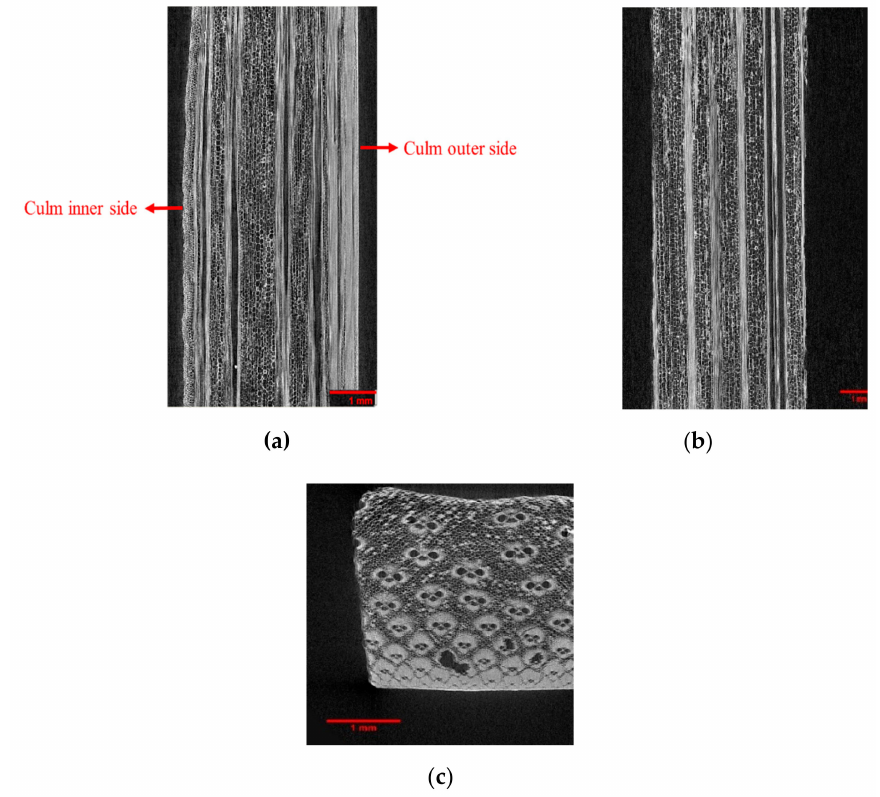
Figure 3. X-ray micro-CT images of virgin bamboo. ( a ) front view, ( b ) side view, and ( c ) top view. The white vertical bundles denote the Xylem while the cellular voids around denote